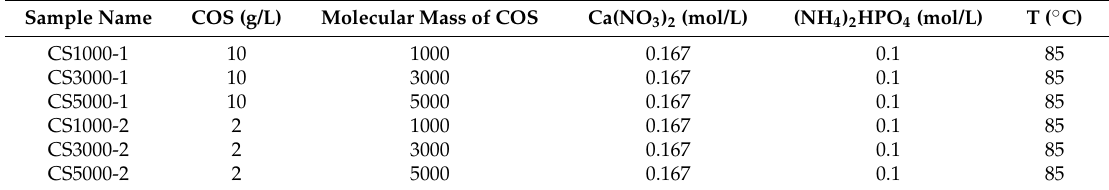
Table 1. Synthesizing conditions for preparing apatites with COS as a